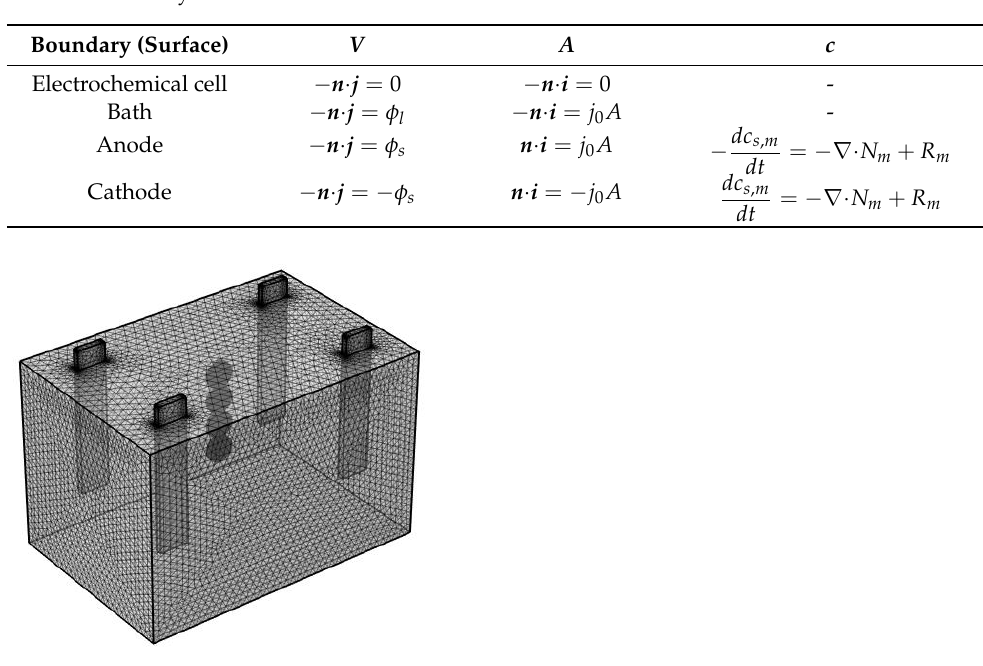
Table 3. Boundary conditions.